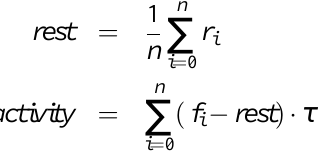
Fig. 6. Measurement